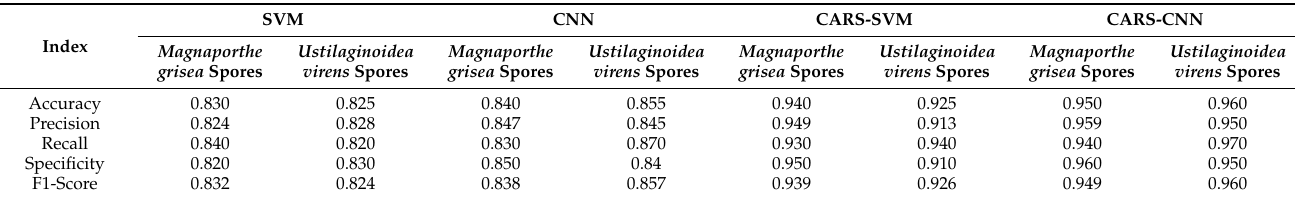
Table 3. Results of different model classification